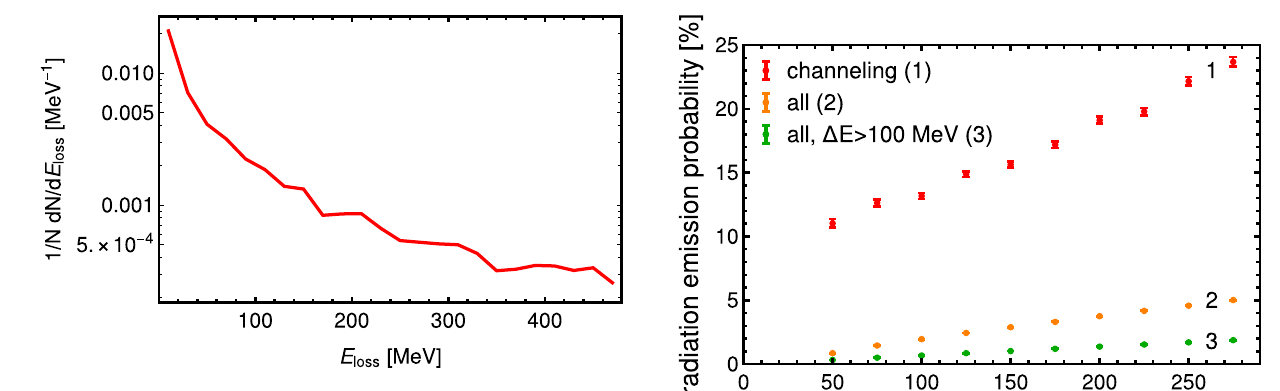
Fig. 10 Radiation energy loss distribution for a 175 µ m thick Si crys- tal, bent along the (111) planes with a deflection angle of 1.75 mrad. The incoming beam distribution is the same as in Fig. 5